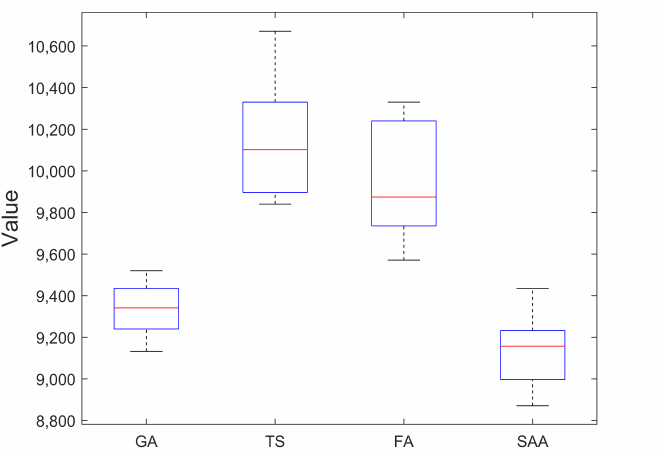
Figure 6. Boxplot for the process of 50 × 10.